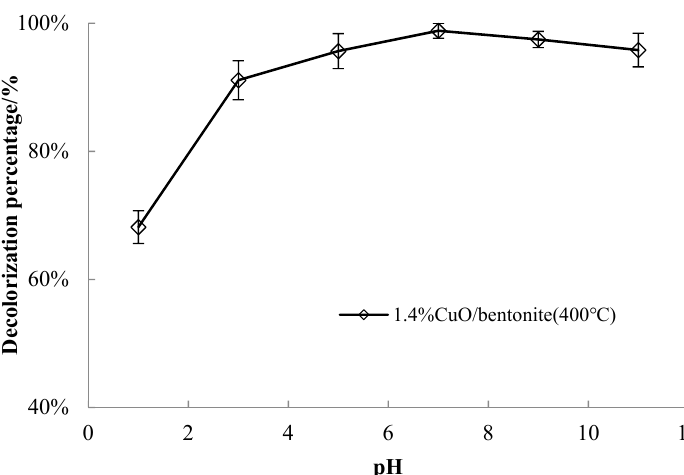
Figure 7. Effect of solution pH on catalyst performance.